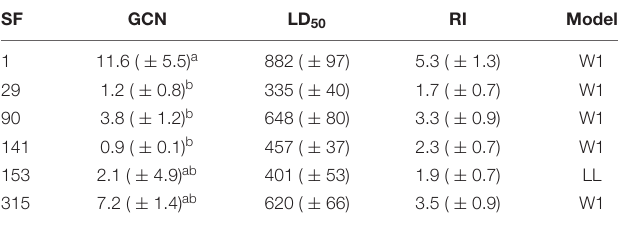
TABLE 2 | Seed family (SF) Gene copy number (GCN) of 5-enolpyruvylshikimate-3-phosphate synthase ( EPSPS ) relative to carbamoyl phosphate synthetase ( CPS ) and acetolactate synthase ( ALS